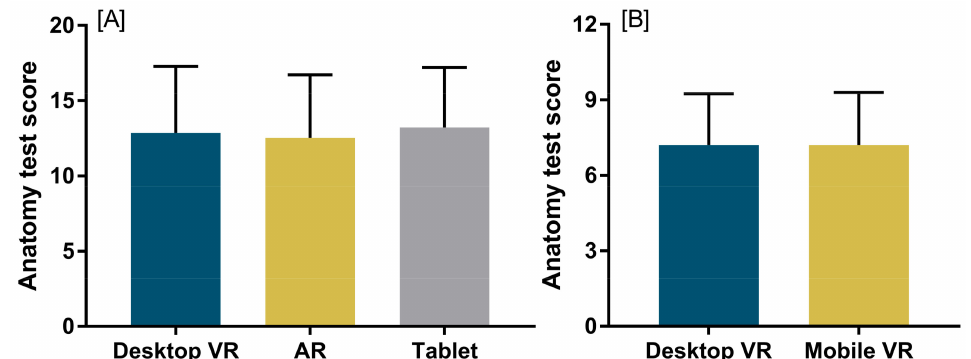
Figure 1. ( A ) Results in an anatomical written assessment (mean ± SD) for participants who learnt using Oculus Rift virtual reality (VR) without touch controllers, augmented reality (AR), or tablet. Full data published in [21]. ( B ) Comparison of test results from students utilizing either Oculus Rift VR or mobile-based virtual reality devices. Full data published in